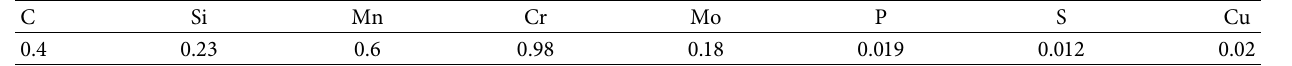
Table 1: Chemical composition of 42CrMo steel (wt%).